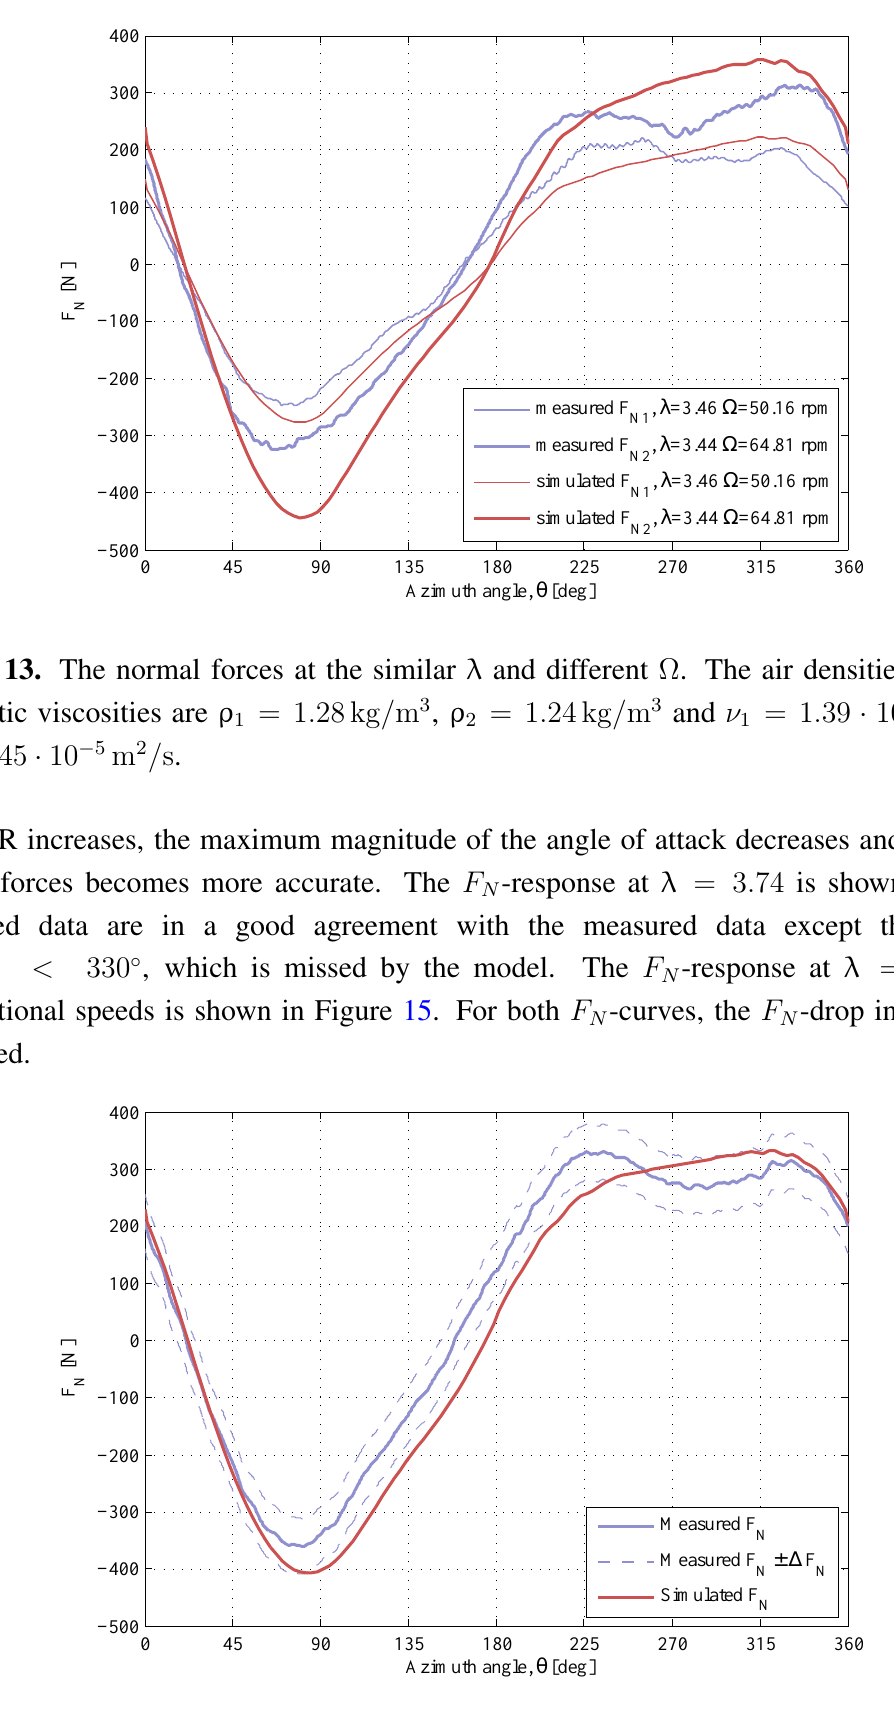
Figure 14. The normal force at λ = 3 . 74 , Ω = 65 . 07 rpm . The air density and the kinematic viscosity are ρ = 1 . 24 kg / m 3 and ν = 1 . 44 · 10 − 5 m 2 / s